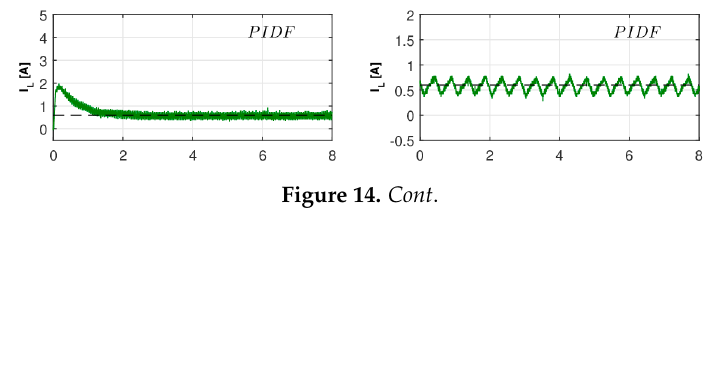
Figure 13. Simulated step responses using IMC-Chien method, the pole placement method and pole-zero control method in the continuous-time case: output voltages and control signals. Table 3. Phase margin variations from continuous to discrete-time control using backward Euler’s discretization method.